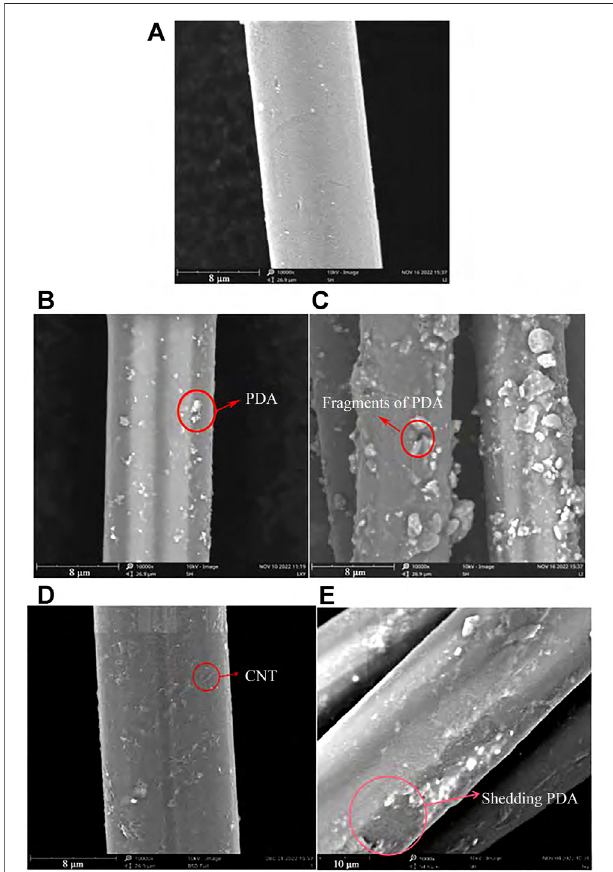
FIGURE 1 | Surface morphology of aramid fi ber before and after modi fi cation: (A) AF, (B) AF-PDA, (C) AF-PDA for 30 min, (D) AF-PDA-0.03% CNT, (E) AF-PDA-0.03% CNT for 30